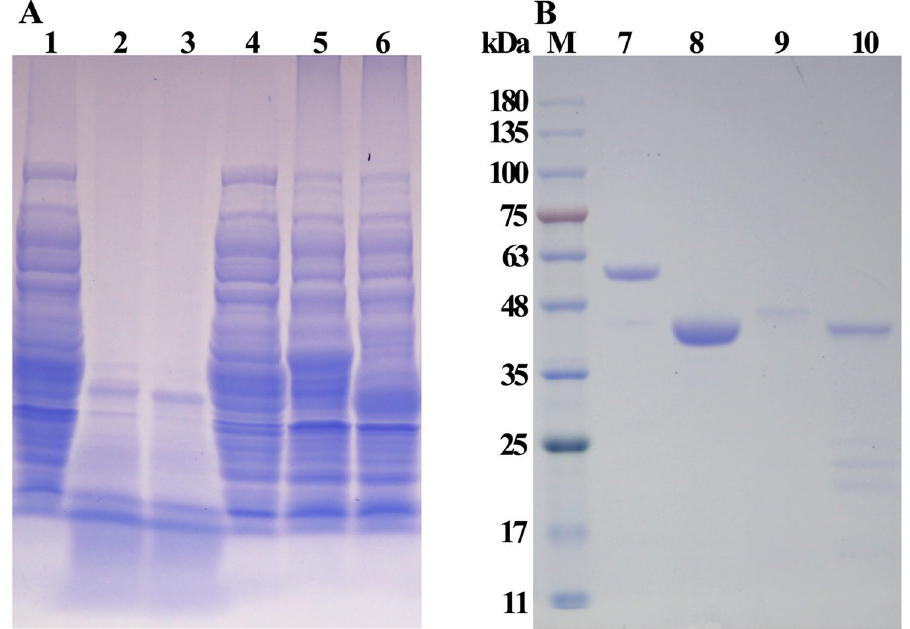
Figure 4. SDS-PAGE analysis of recombinant AprA and AprA-PPC. ( A ) The supernatant of crude extract from E. coli BL21 (DE3) PlysS expression strains. Lane 1, control containing pET28a without 10 mM PMSF; lane 2, AprA crude extract without 10 mM PMSF; lane 3, AprA-PPC crude extract without 10 mM PMSF; lane 4, control containing pET28a with PMSF; lane 5, AprA crude extract with PMSF; lane 6, AprA-PPC crude extract withPMSF. ( B ) The purified enzymes. Lane 7, purified recombinant AprA with 10 mM PMSF; lane 8, purified recombinant AprA-PPC with 10 mM PMSF; lane 9, purified recombinant AprA without PMSF; lane 10, purified recombinant AprA-PPC without PMSF. Lane M, molecular weight